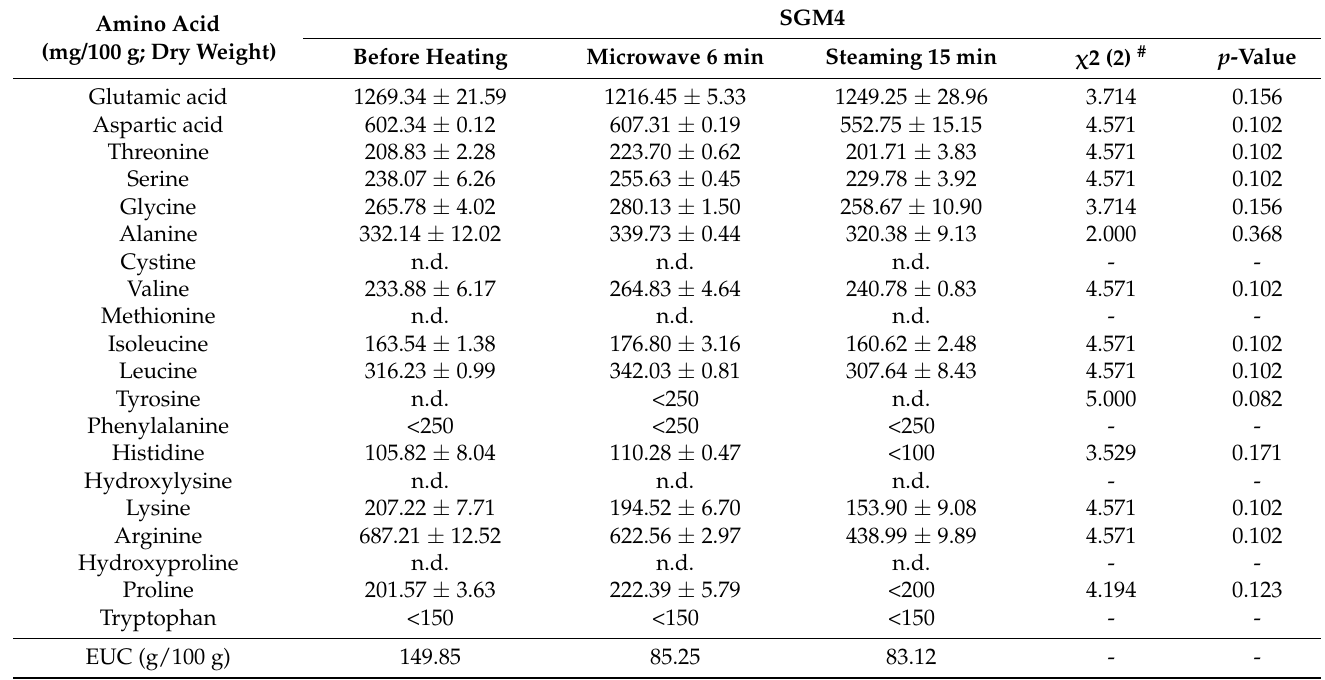
Table 3. Free amino acids of SGM4 before and after heat